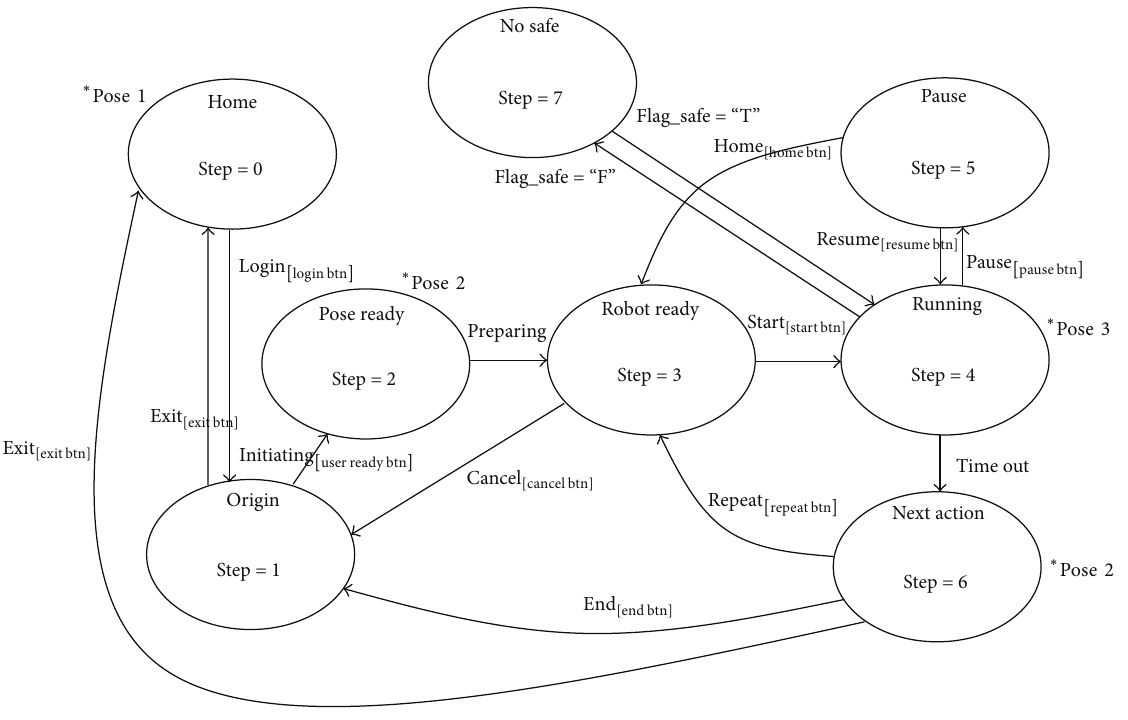
Figure 4: SEFRE state